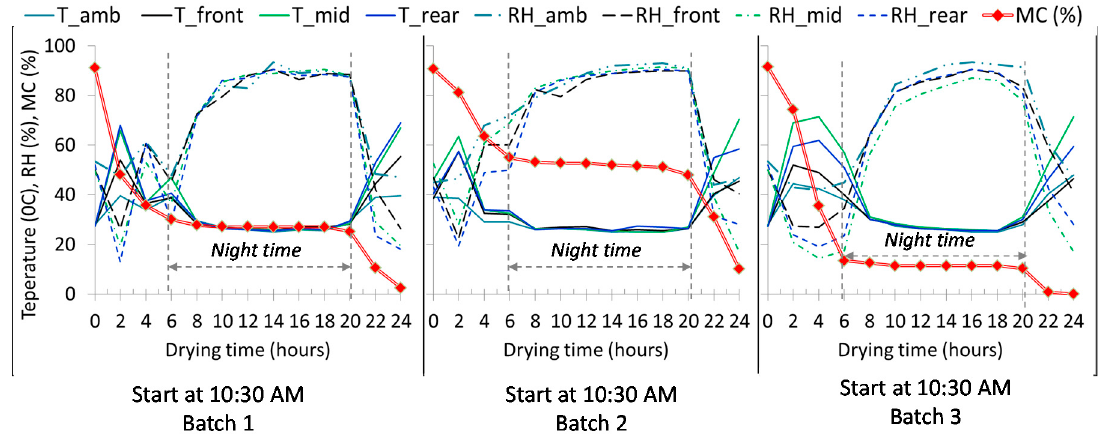
Figure 5. Correlation of ambient temperature, RH, and mushroom MC reduction during 3 drying batches. Table 4. C and N contents of mushrooms before and after drying.